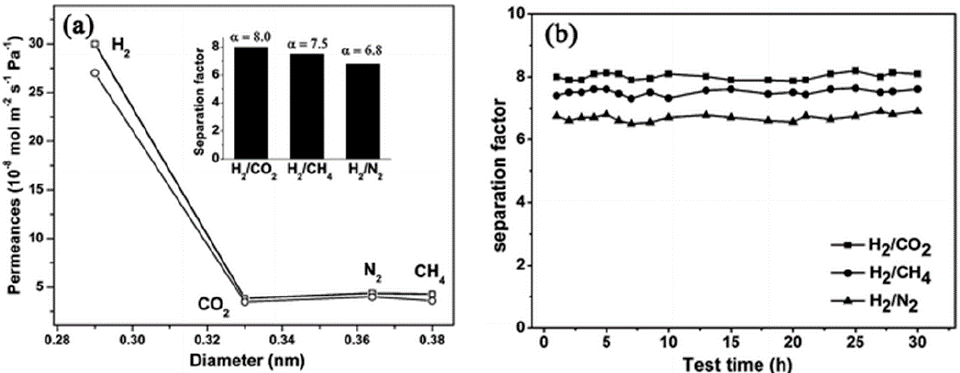
Figure 36. ( a ) Single- ( □ ) and binary- ( ○ ) gas permeances of different gases on the Cu(bipy) 2 (SiF 6 ) membrane at 293 K as a function of the kinetic diameter (inset: the separation factor for H 2 over other gases by binary gases tests). ( b ) Plot of H 2 –CO 2 , H 2 –CH 4 and H 2 –N 2 separation factors of the Cu(bipy) 2 (SiF 6 ) membranes (average values of five different membranes) at different test times. Permeation temperature = 293 K, feed pressure = 1 × 10 5 Pa (adapted with permission from ref. [134]).